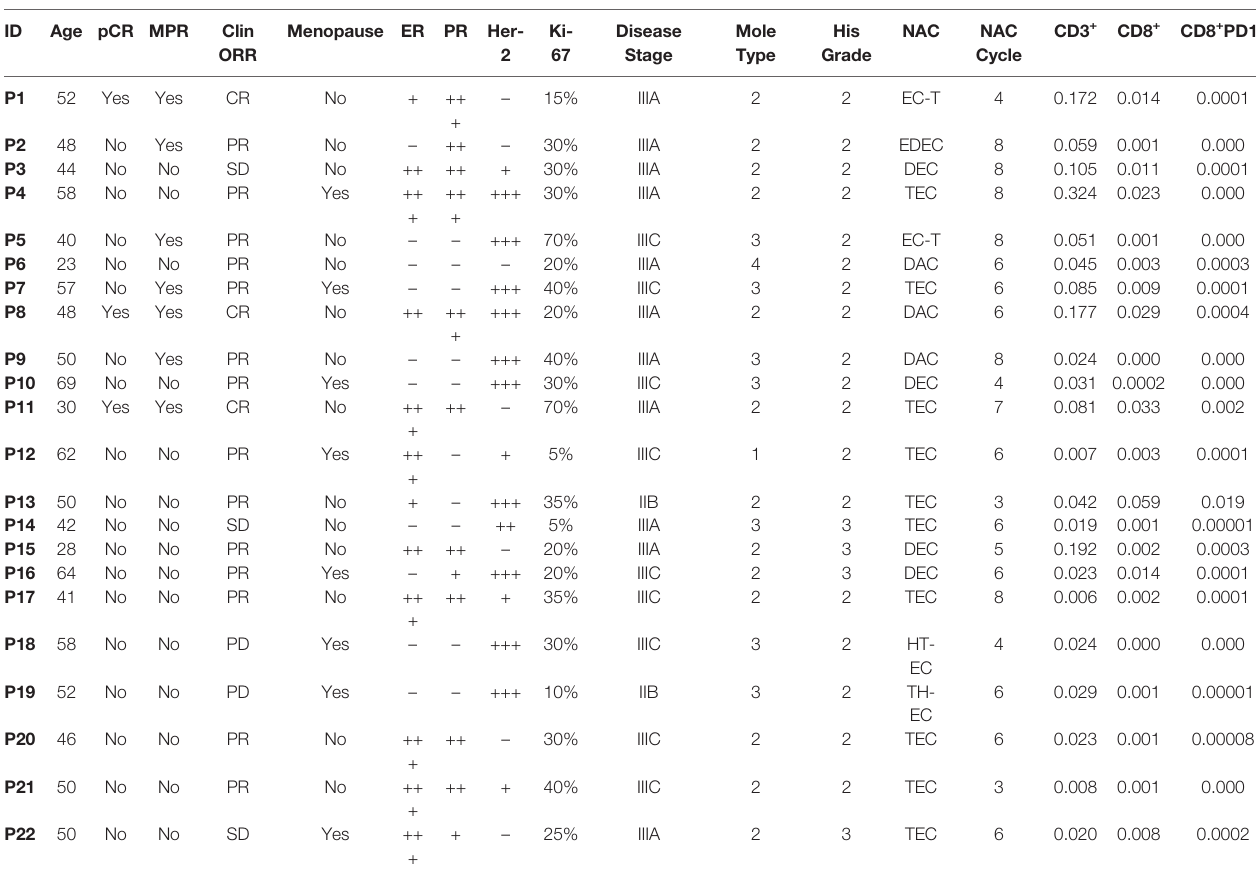
TABLE 1 | Clinical characteristics of 22 breast cancer patients with paired